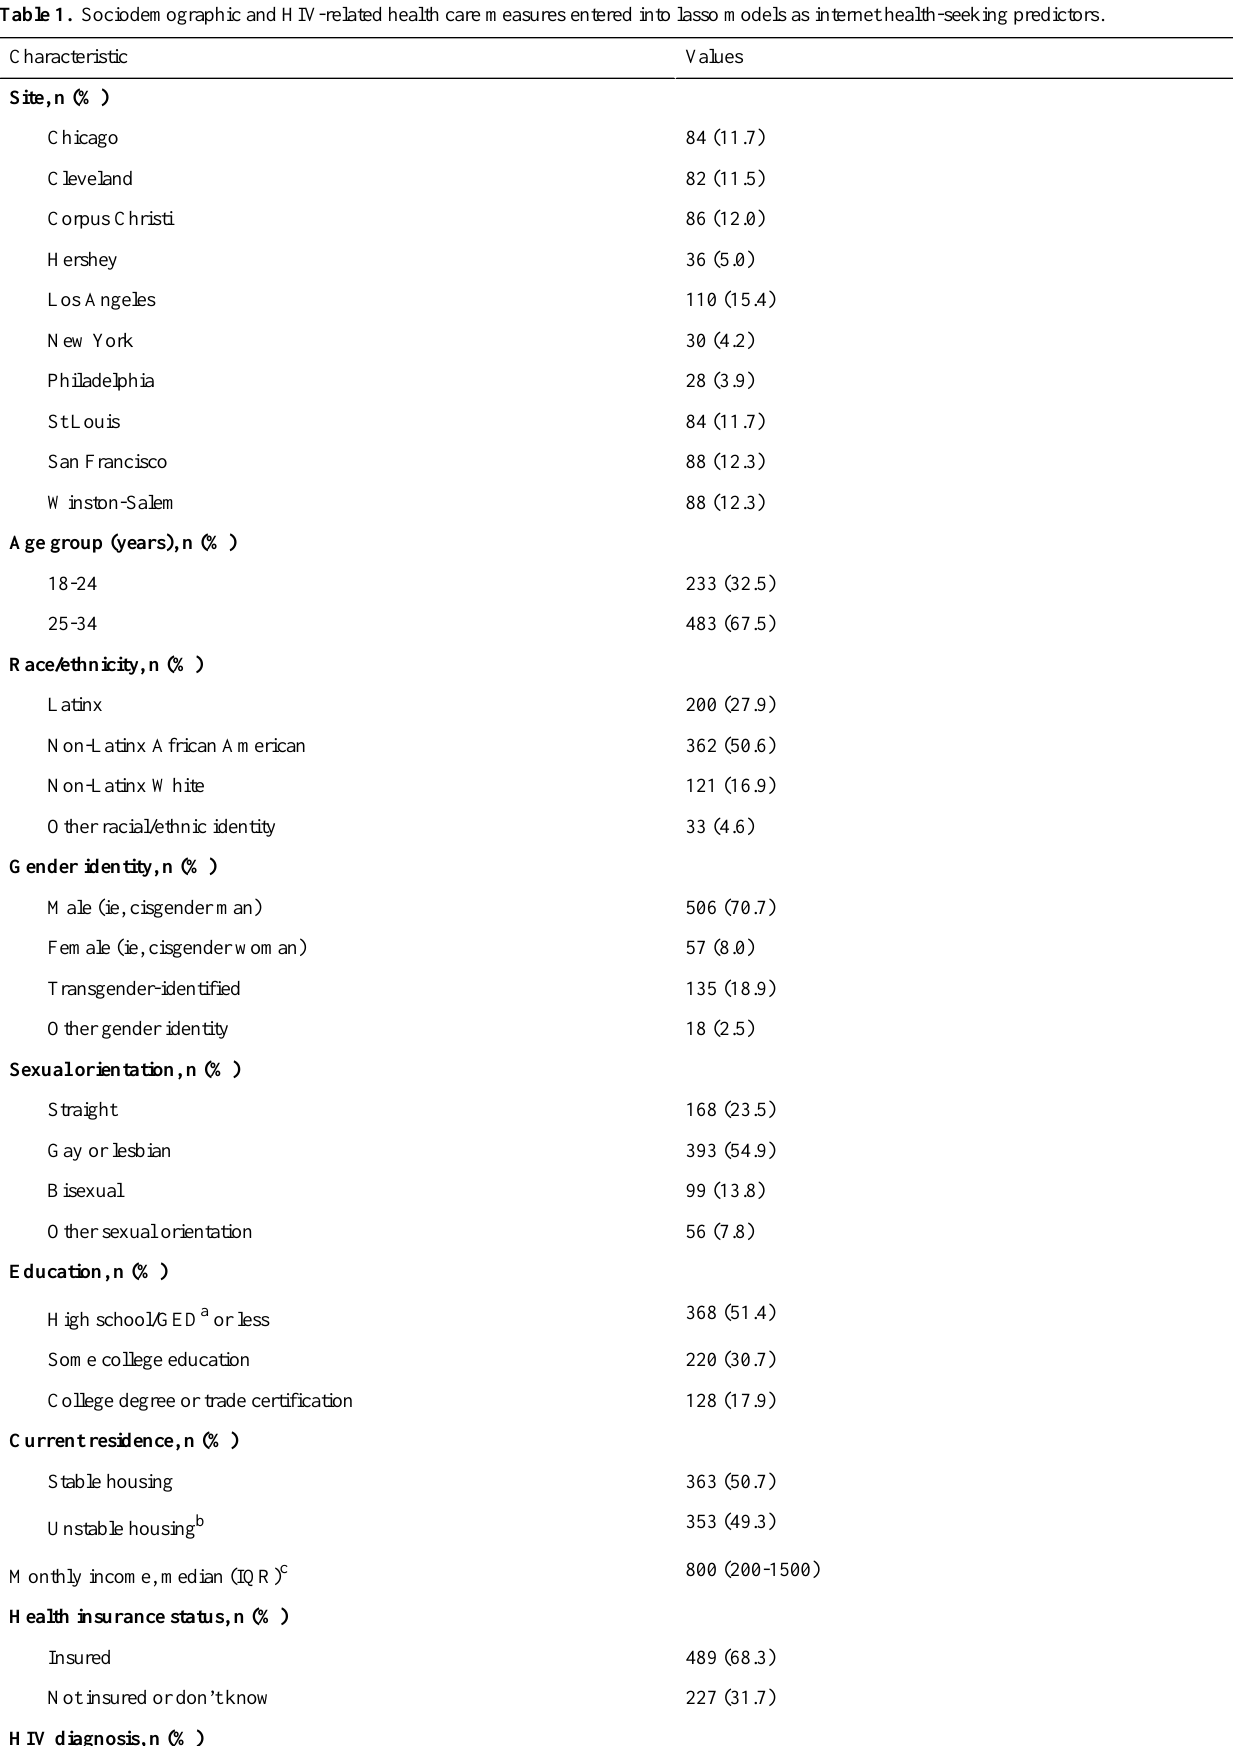
Table 1. Sociodemographic and HIV-related health care measures entered into lasso models as internet health-seeking